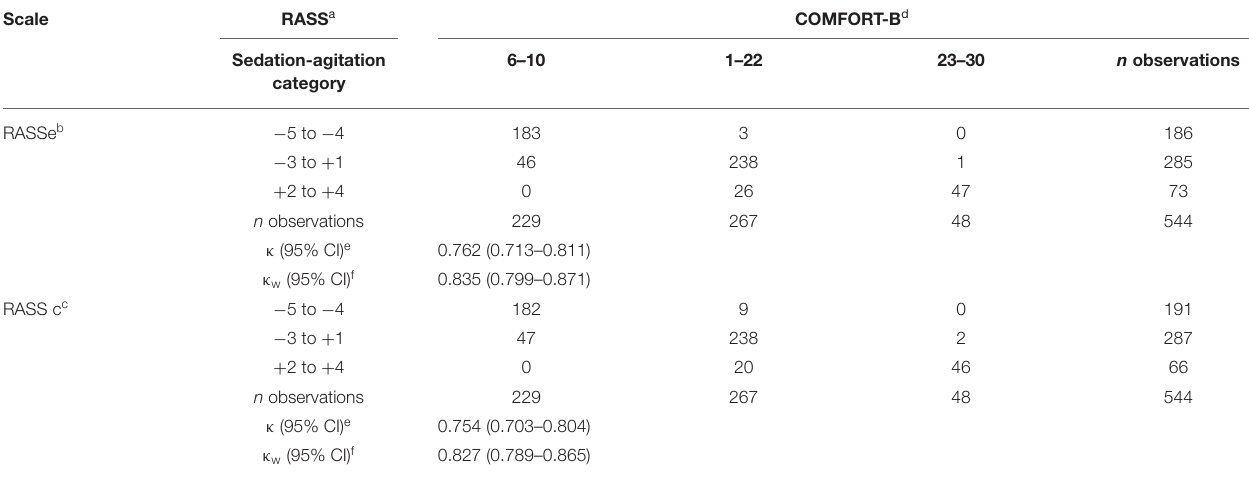
TABLE 4 | Agreement between the Richmond Agitation-Sedation Scale and the COMFORT behavior scale categories ( p < 0.001 in all cases). Scale